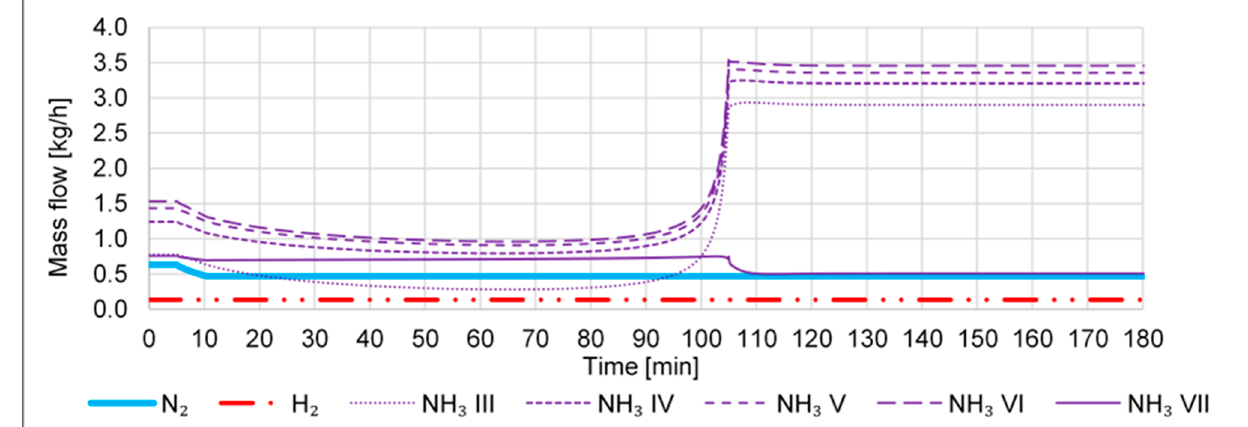
Processes 2023 , 11 , x FOR PEER REVIEW Figure 4 . Selected mass fl ows of scenario (b). Figure 4. Selected mass flows of scenario (b).